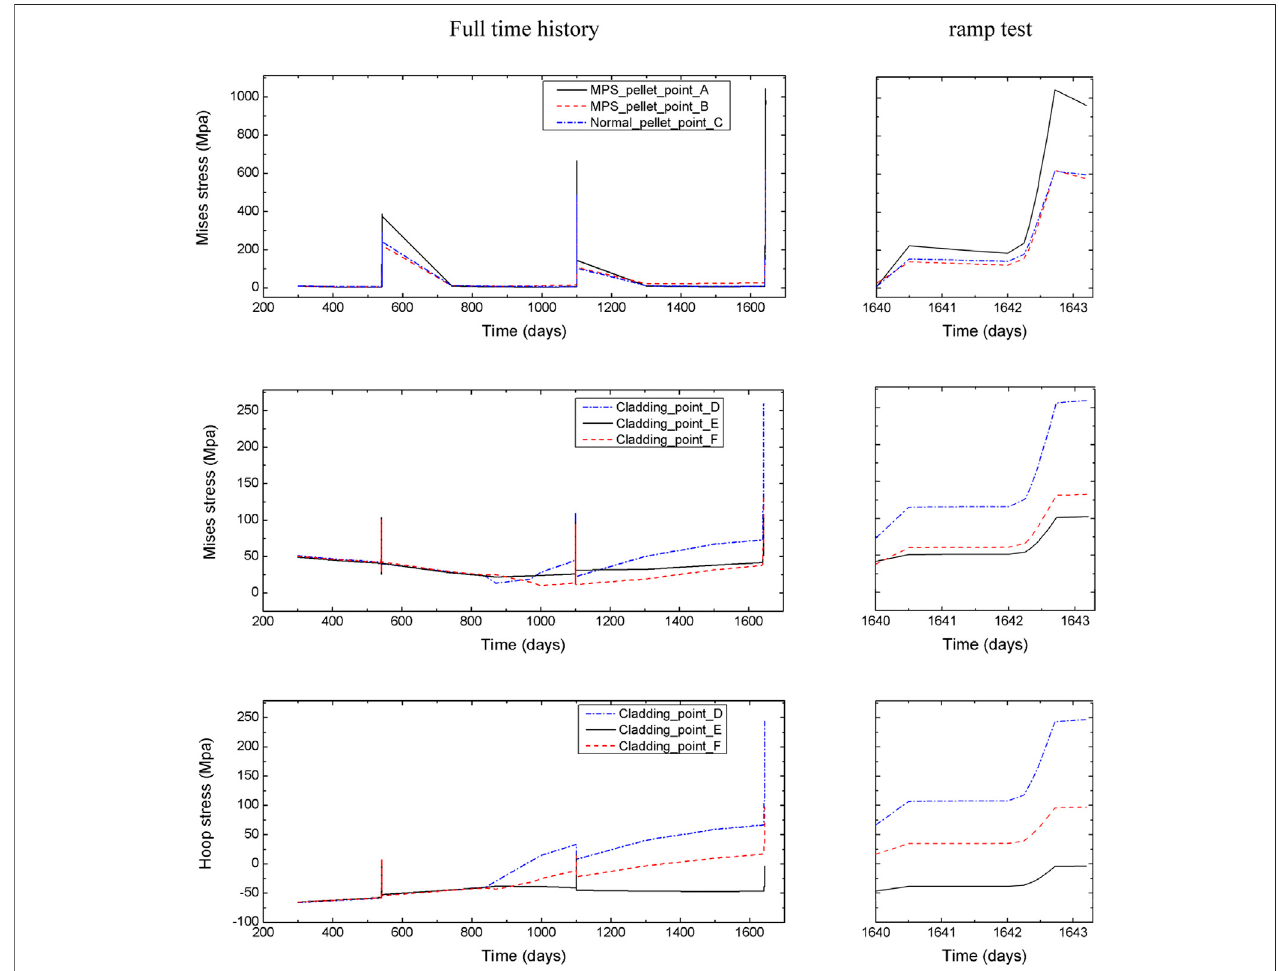
FIGURE 15 | Von Mises and hoop stress distribution in full irradiation history at pre-set points.